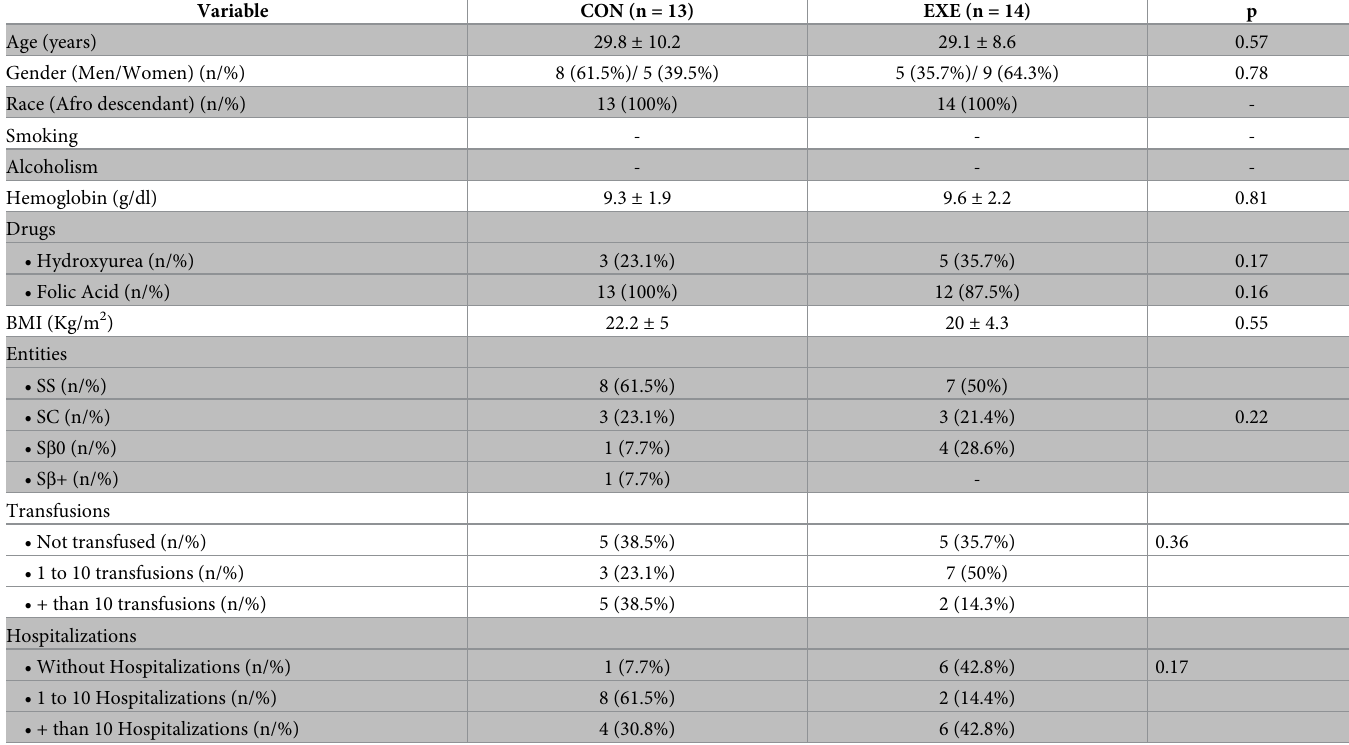
Table 1. Comparison of the demographic, clinical and laboratory characteristics of the control (CON) and exercise (EXE) groups at the initial moment of the study (M0). Variable